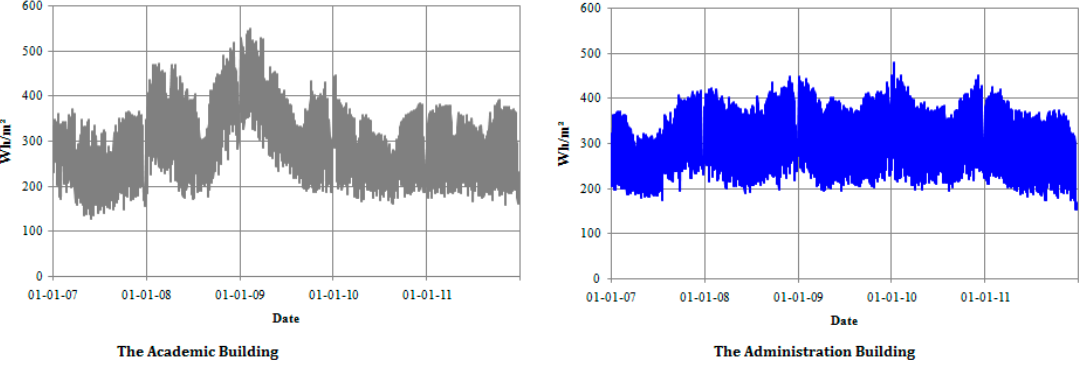
Figure 6. Variation in daily electricity consumption of office and academic buildings [26].